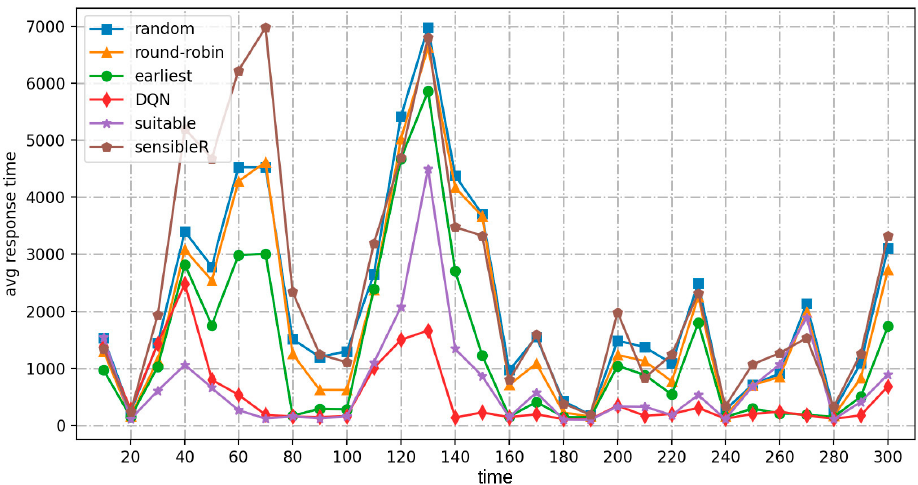
Figure 6. Average response time in random workload mode.